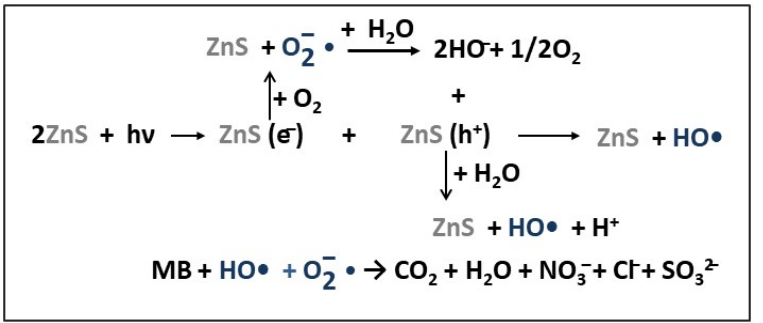
Figure 4. The reaction mechanism proposed for MB dye degradation under UV light irradiation, in presence of 1D ZnS photocatalyst.